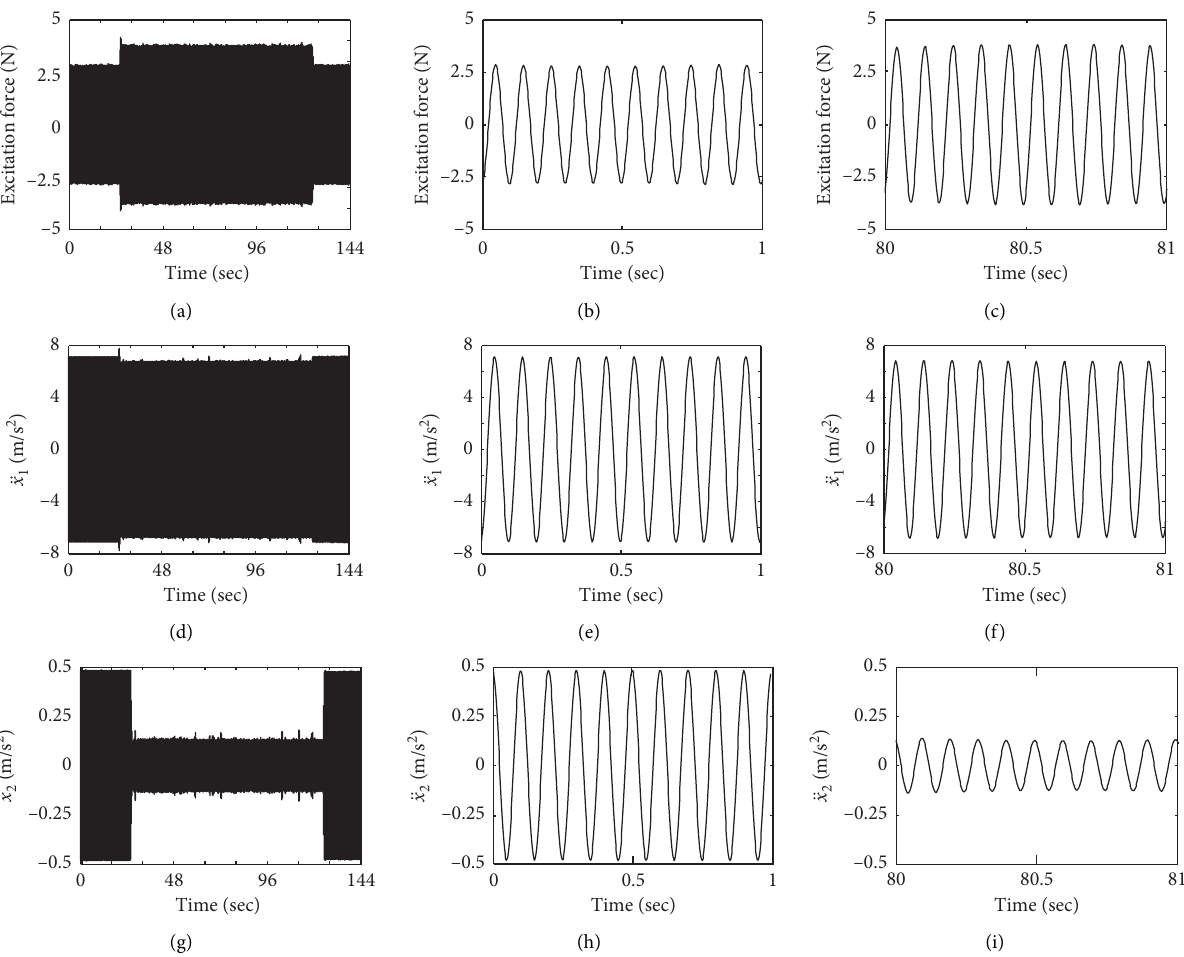
Figure 10: Measured time histories of excitation force and system acceleration when Ω � 10 Hz (for t < 25s and t > 125s, α � 0 . 25, α � − 0 . 455, and τ � 30ms): (a) excitation force; (d) absorber; (g) primary system; (b, c) zoom of (a); (e, f) zoom 25s ≤ t ≤ 125s, α 1 2 2 of (d); (h, i) zoom of (g).